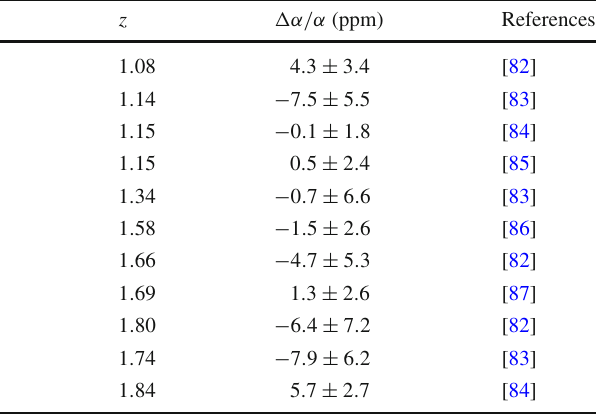
Table 1 Compilation of recent measurements of the fine-structure con- stant obtained by different spectrographic methods. For details in each case, see the corresponding